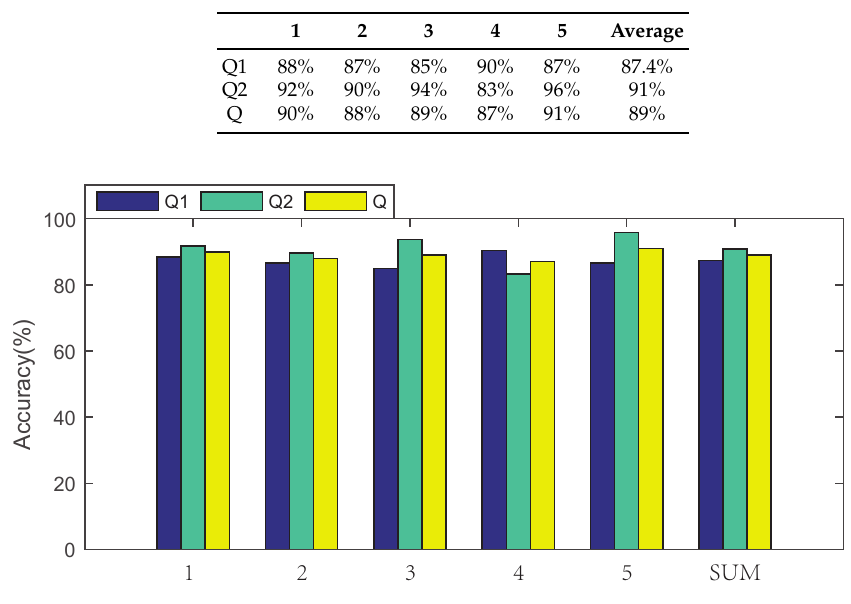
Table 7. Accuracy of five test experiments.